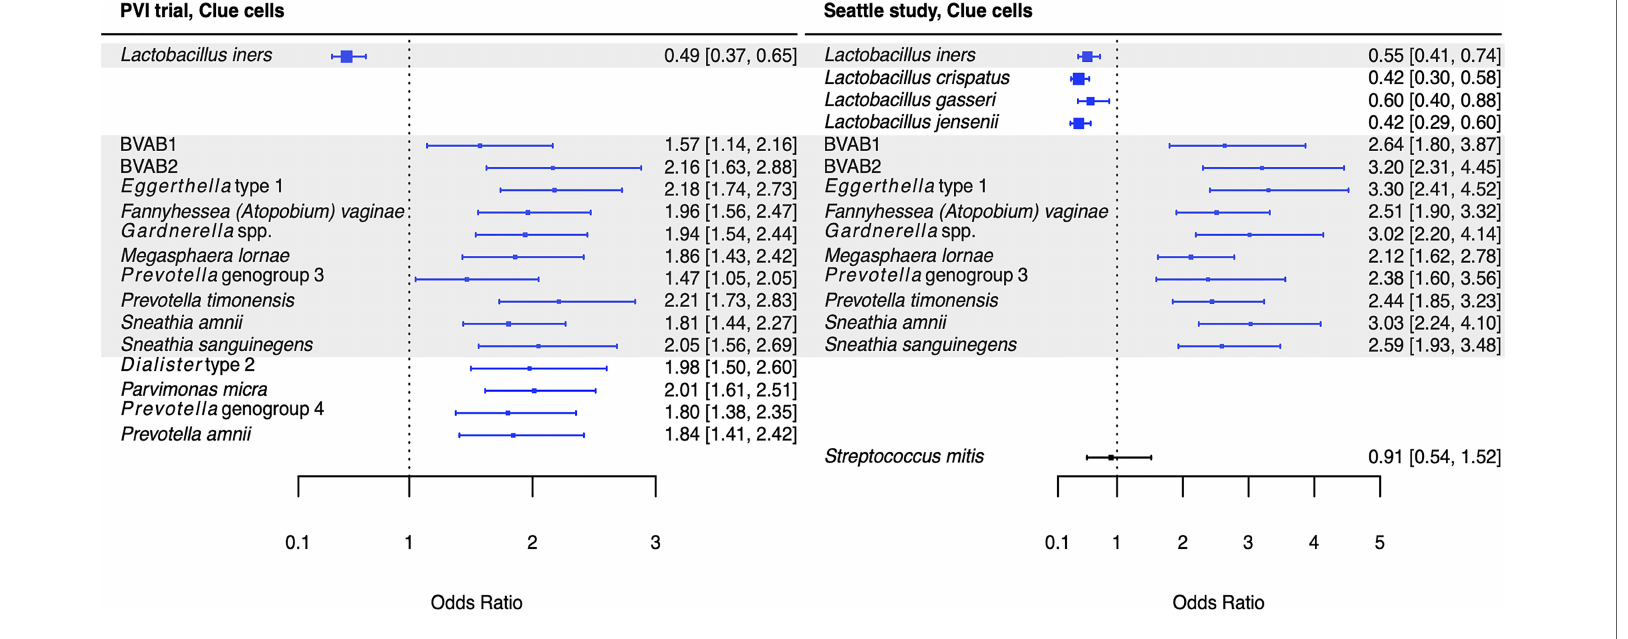
FIGURE 3 | Logistic regression modeling results for the association between vaginal bacteria and clue cells. Gray shading indicates taxa that were modeled in both study populations. Blue box and whiskers indicate associations that were signi fi cant following Benjamini-Hochberg multiple comparisons adjustment (5% false discovery rate), and black box and whiskers indicate associations that were not signi fi cant following multiple comparisons adjustment. All models were univariable logistic regression models with the Amsel criterion as the outcome and bacterial relative abundance as the exposure. Bacterial relative abundances were modeled as tertiles with the reference level being no detection (four-level ordinal variables with levels: no detection, tertile 1, tertile 2, tertile 3). Generalized estimating equations with an independent correlation structure were used for PVI trial models, and no variables were lagged in PVI models. PVI, Preventing Vaginal Infections; OR, odds ratio; CI, con fi dence interval; BVAB, bacterial vaginosis associated